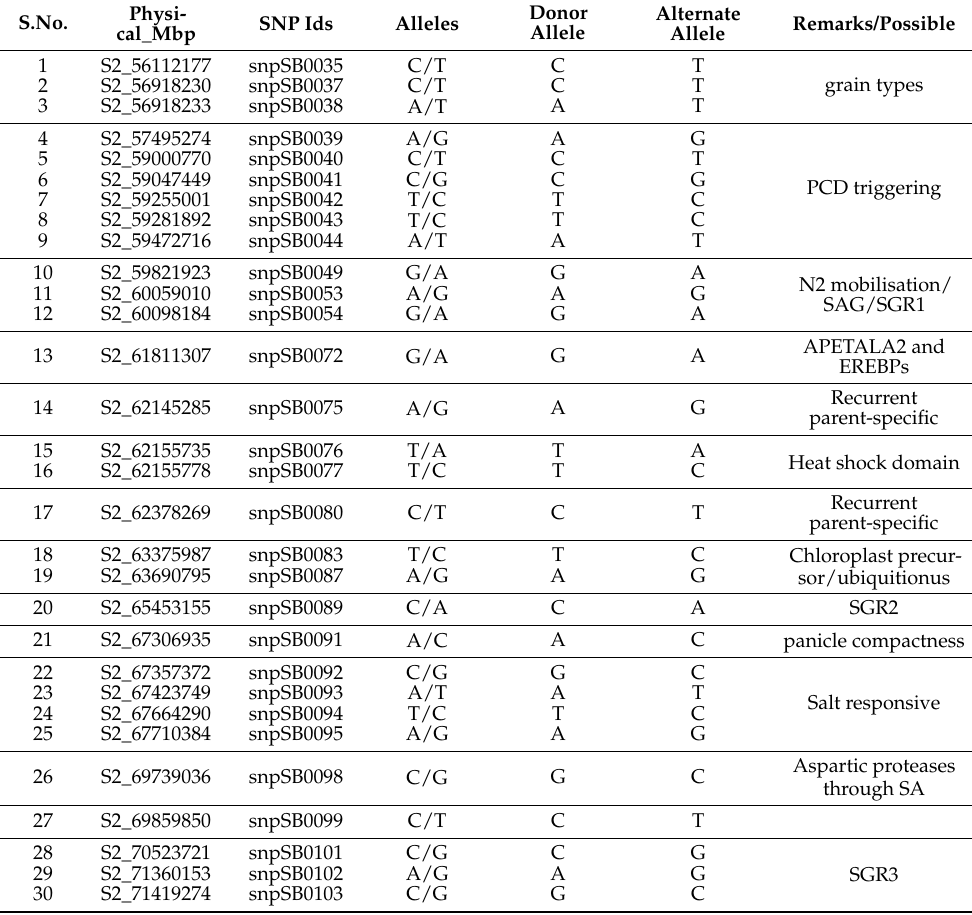
Table 1. List of SNPs markers associated with STG QTLs used for genotyping sorghum. S.No. Physi- cal_Mbp SNP Ids Alleles